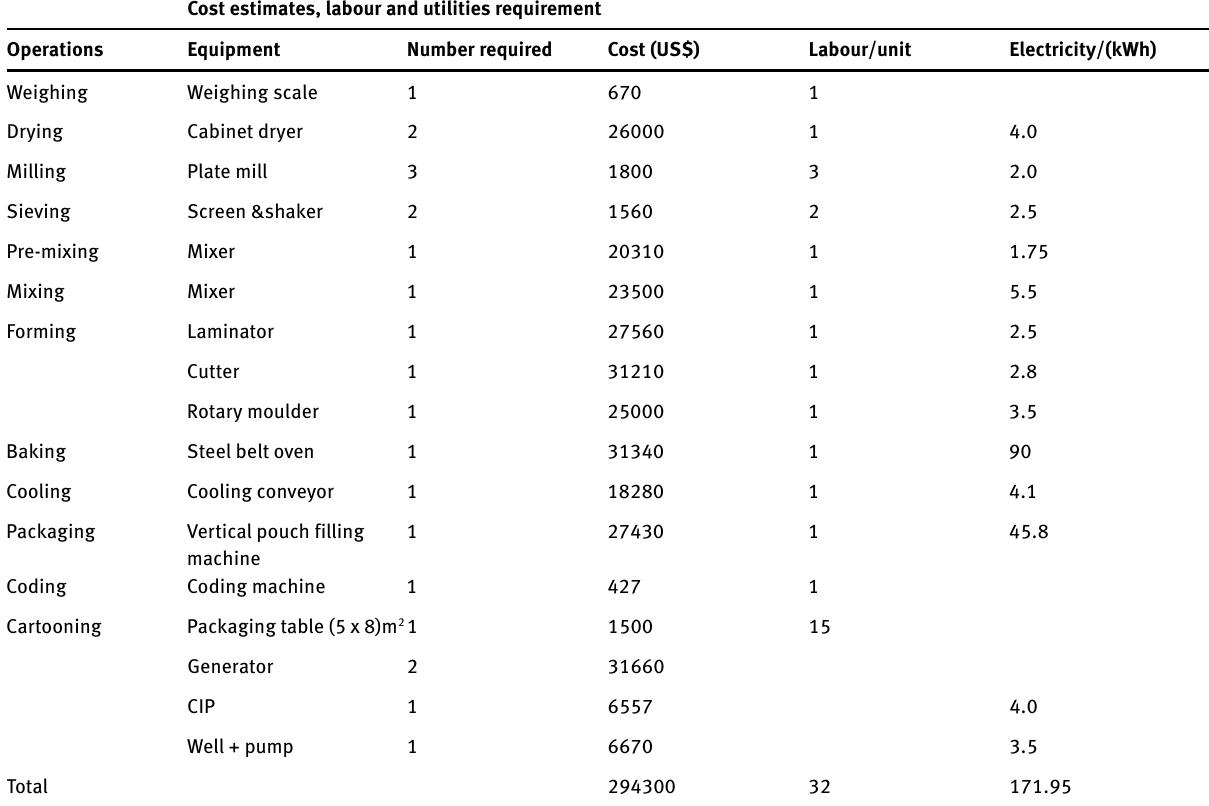
Table 1: Estimate of major equipment and cost of cookies in (250g)